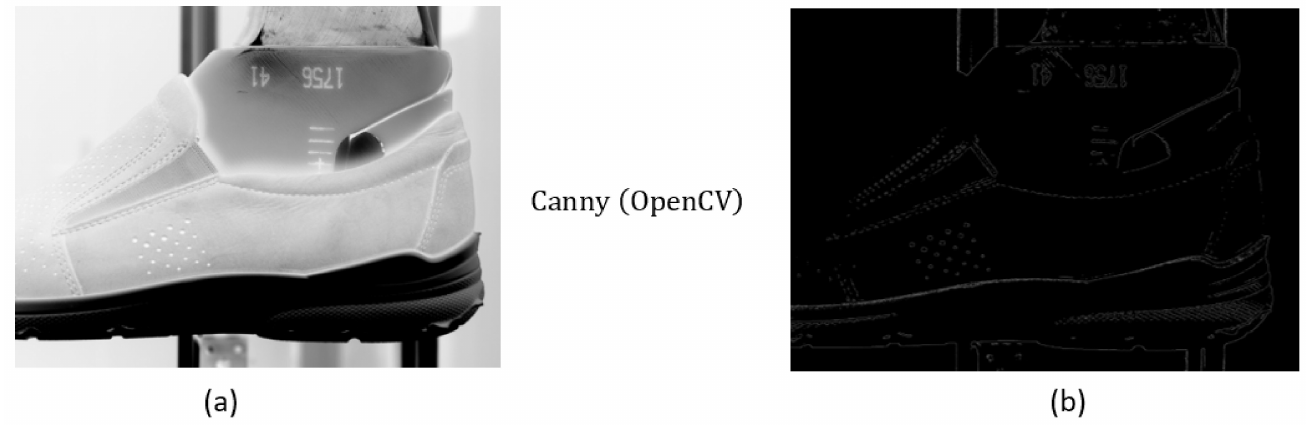
Figure 6. Original ( a ) and filtered by Canny algorithm ( b )